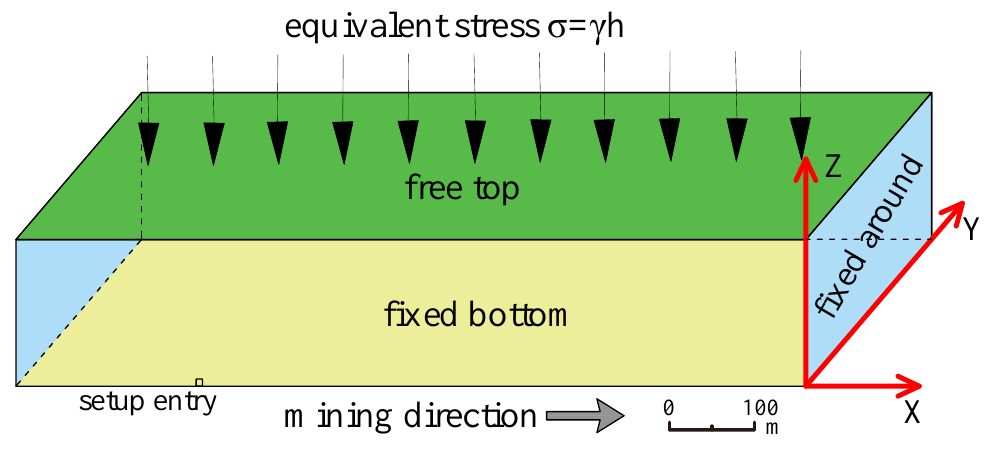
Figure 3. Model boundary condition.